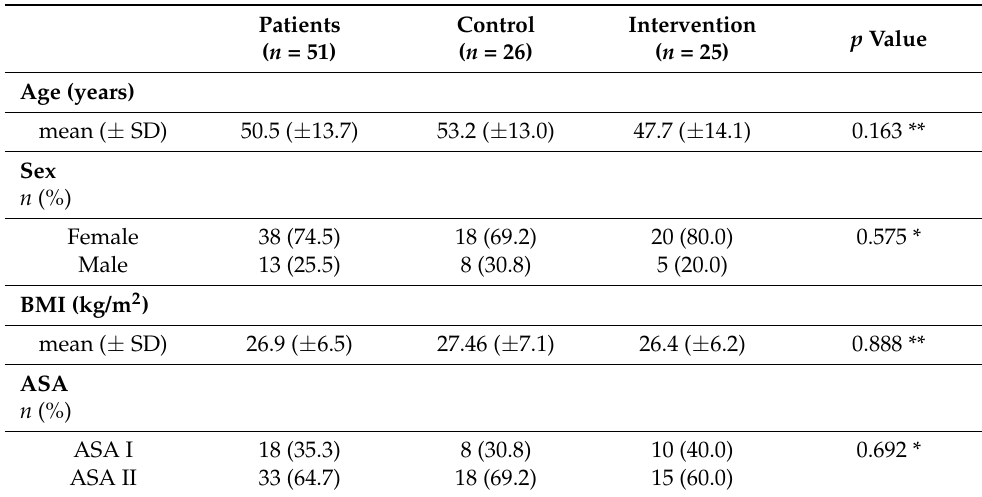
Table 1. Demographics data of the study. BMI = body mass index; ASA = American Society of Anesthesiology Status; SD = standard deviation; * chi-square test, ** Mann–Whitney test.